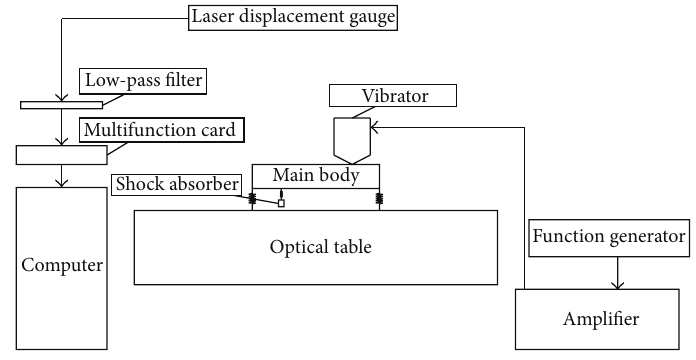
Figure 5: Schematic diagram of experimental setup.